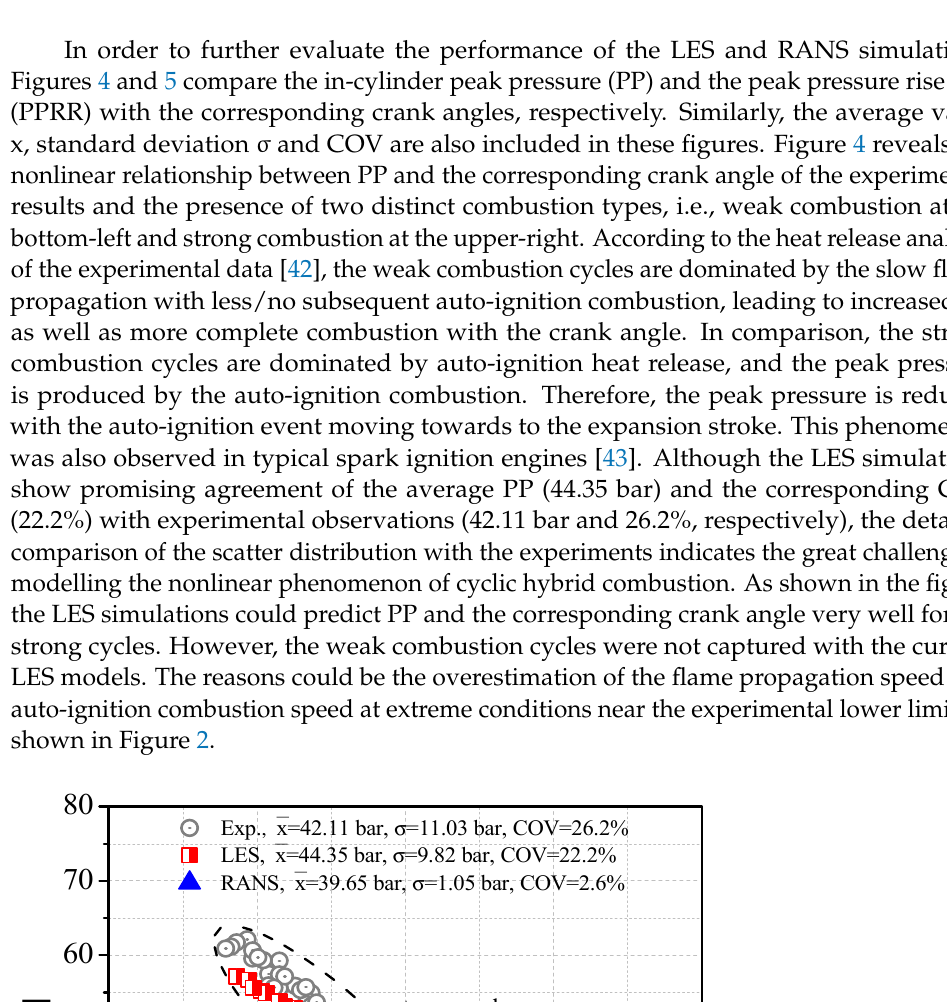
Figure 5. The scatter plot of the in-cylinder peak pressure rise rate (PPRR) and the corresponding crank angles. The two distinct combustion types can also be observed in Figure 5. The weak com- bustion cycles with peak pressure rise rate (PPRR) below 2 bar/°CA are located before TDC, while the strong cycles with PPRR ranging between 1 and 20 bar/°CA are located after TDC. Although there are noticeable differences between the predicted and measured average PPRR and COV, the LES simulations were able to predict the two distinct com- bustion types. However, the LES produced fewer number of weak cycles and the corre- sponding crank angles closer to TDC than the experimental observations. In addition, the LES predicted more retarded crank angles of PPRR for some strong cycles, indicating very the late auto-ignition processes for those cycles in LES. As shown in Figures 4 and 5, the RANS simulations could not capture the two distinct combustion types of the SI–CAI hybrid combustion. The predicted average PP (39.65 bar) is close to the experimental value (42.11 bar), but the predicted PPRR (1.63 bar) is signifi- cantly lower than the experimental result (4.04 bar/°CA). The predicted COVs of PP and PPRR by RANS are far lower than the experimental observations. Figure 6a shows the average crank angles with the mass fraction of fuel burned at 10%, 50% and 90% (CA10, CA50 and CA90). The predicted CA50 by LES is slightly later